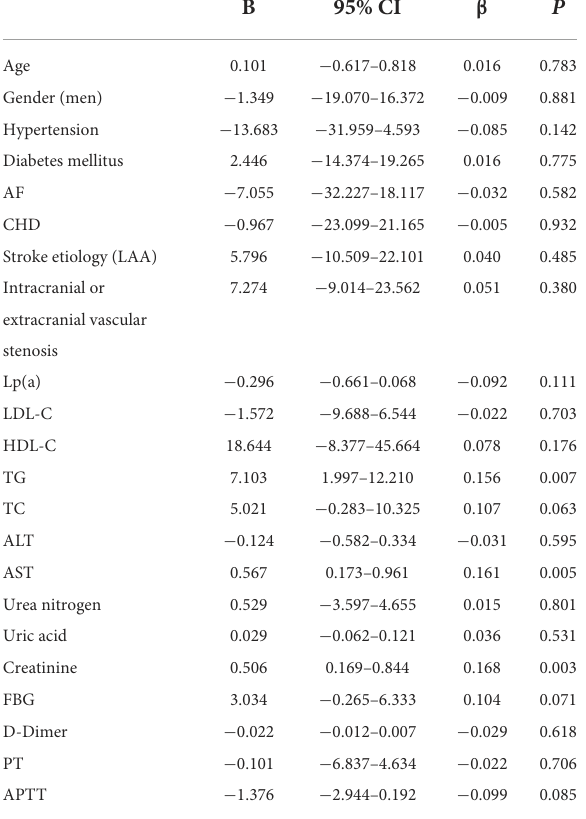
differences were observed in other baseline